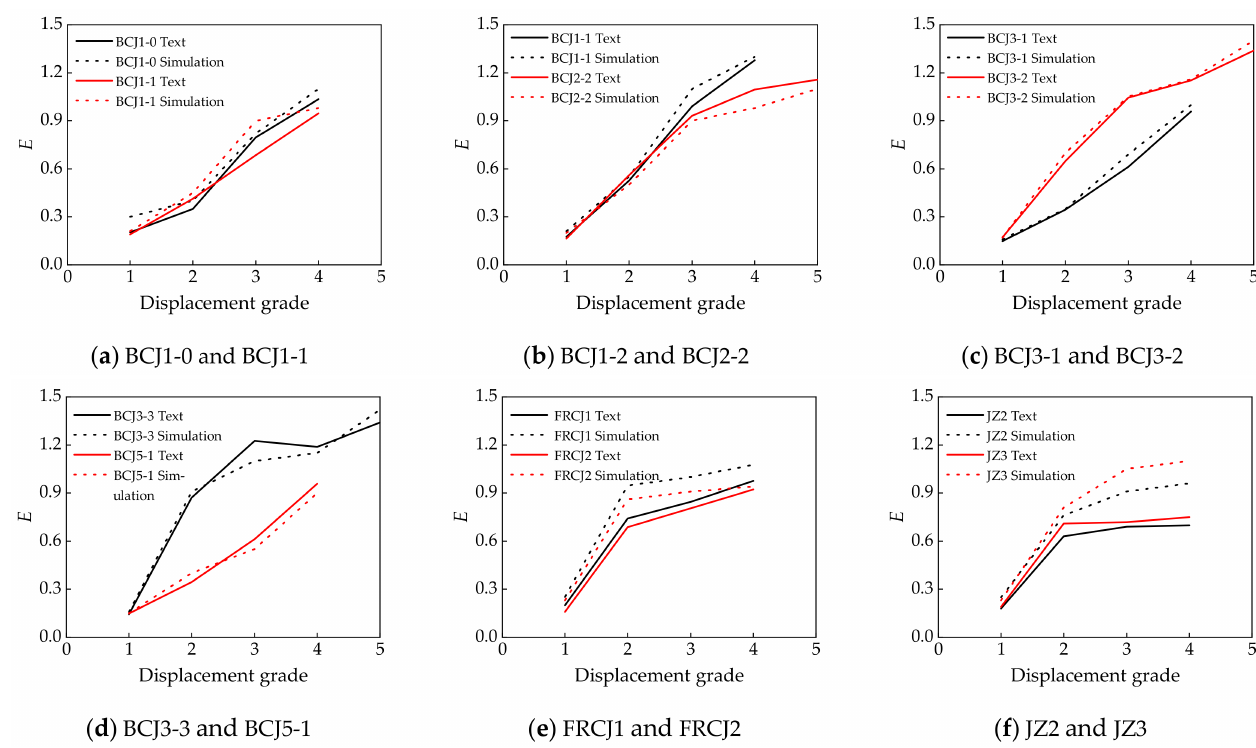
Figure 14. Relationship between energy dissipation coefficient and displacement grade.